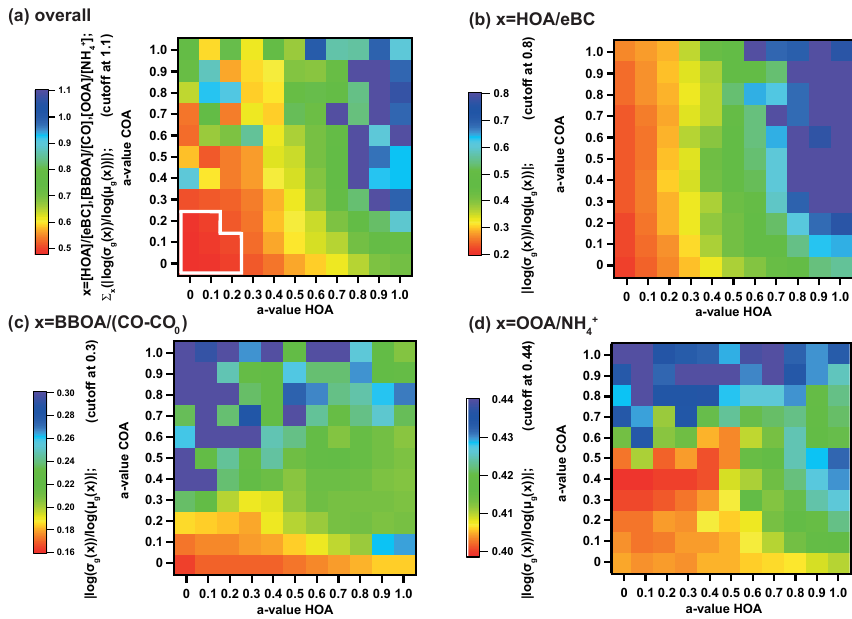
Figure 8. Relative width of the distributions (cid:0) c j /c marker (cid:1) displayed as a function of a HOA and a COA . Panel (a) shows the sum of the criteria for HOA, BBOA, and OOA being the sum of OOA1 and OOA2. (The chosen solutions are pointed out in the white area.) Panels (b–d) show the individual criteria as a function of the a values of HOA and COA a HOA , a COA